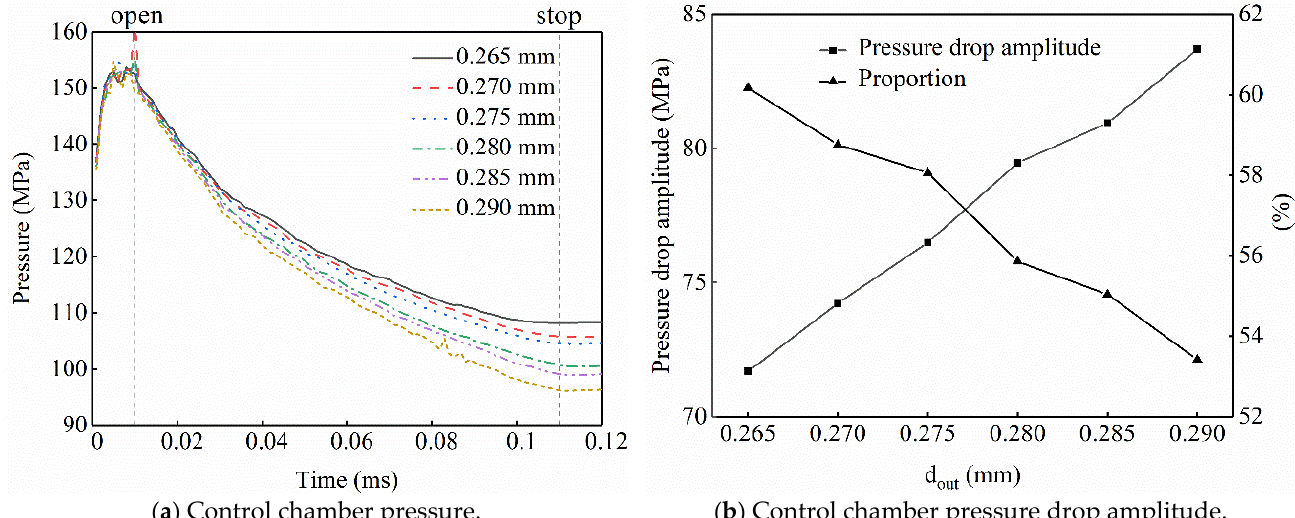
Figure 11. Control chamber pressure variation with outlet throttle diameter.